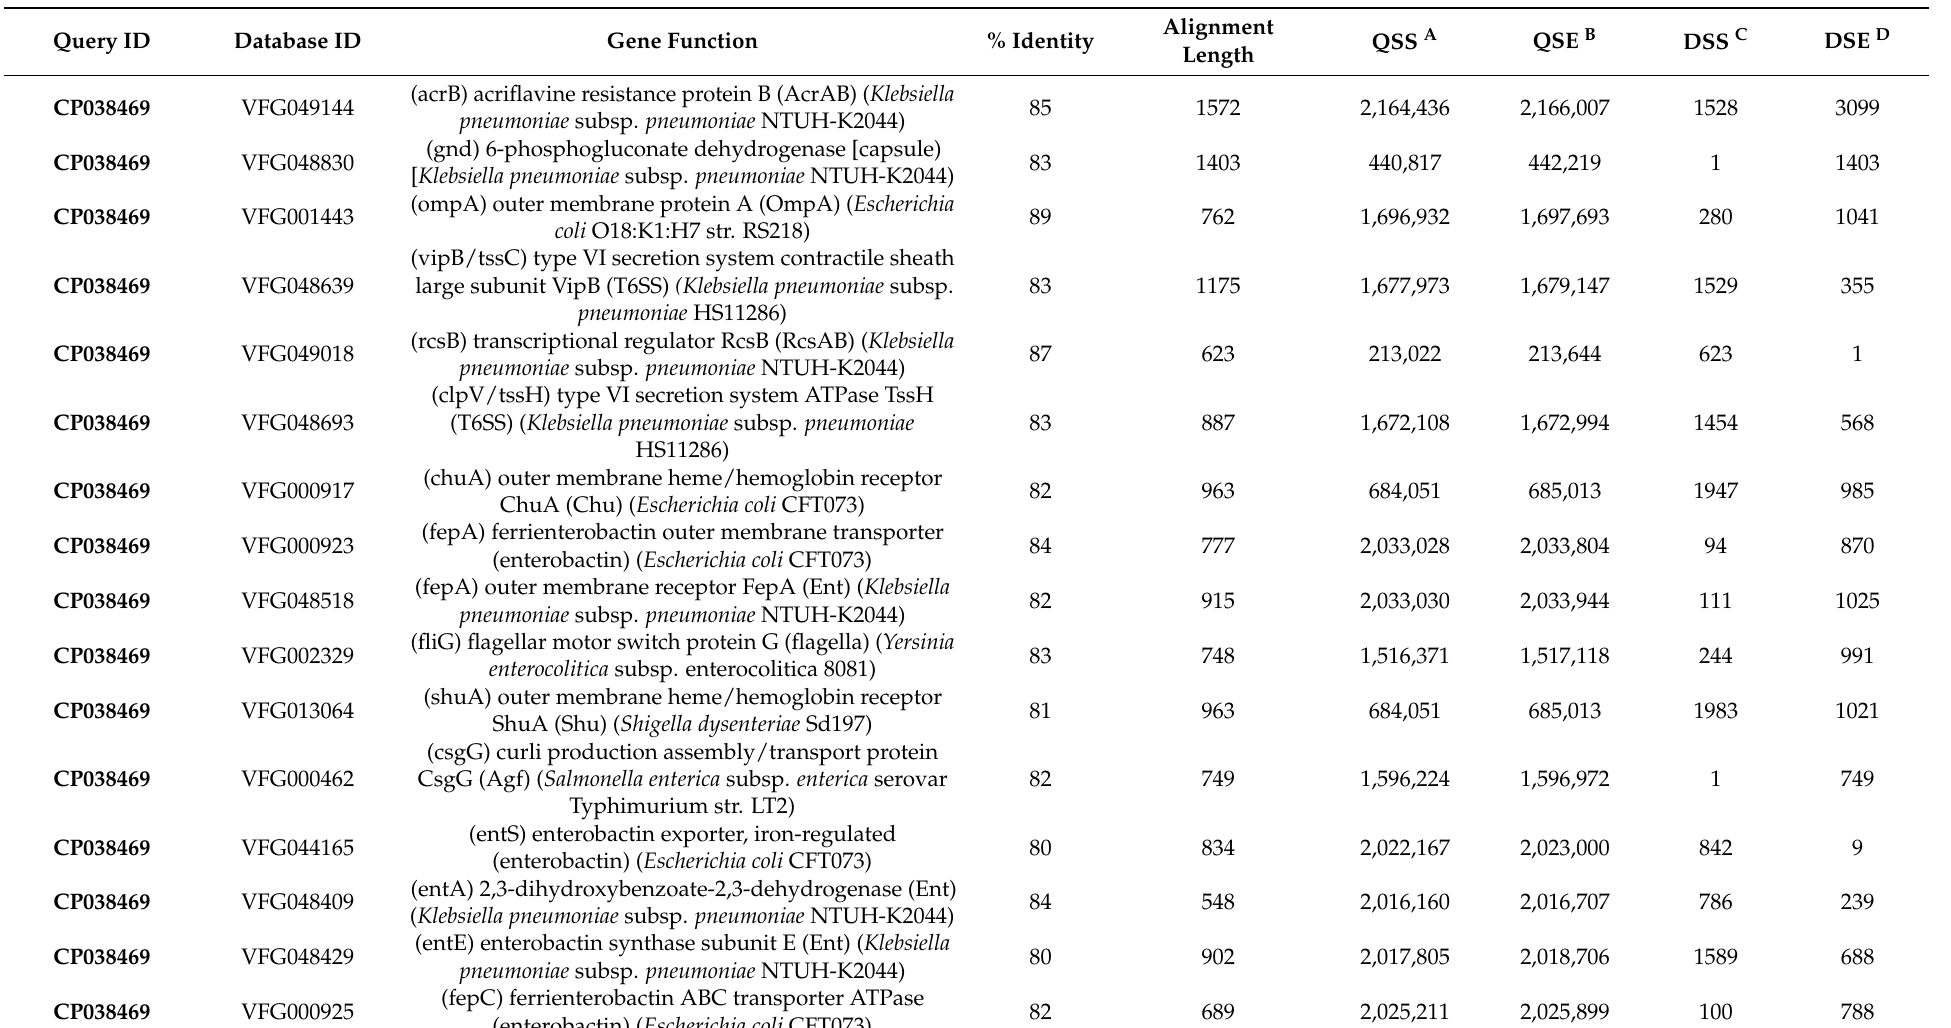
Table 3. Genome fragments related to virulence factors of Citrobacter species located on the strain SNU WT2 compared against database of VFDB [33]. Query